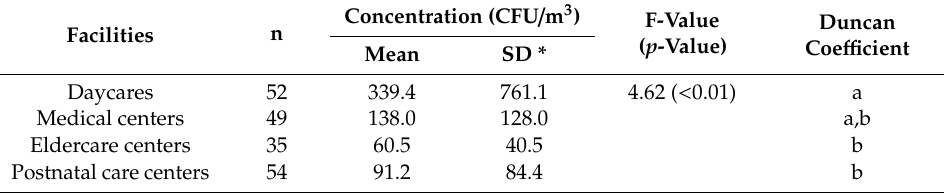
Table 1. Airborne bacterial concentration in indoor air in the target